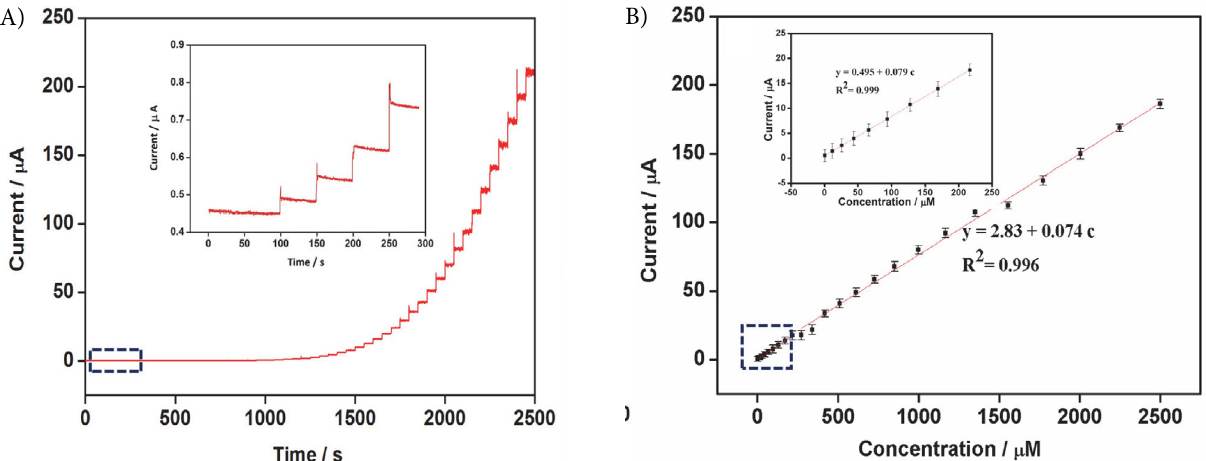
Fig 9. (A) Amperometric responses of the PEDOT/Fe 3 O 4 -CNCC/GCE in stirring PBS (0.2 M, pH 7.4) at an applied potential of 0.8 V to various concentrations of nitrite from 0.5 mM to 2500 mM. Inset shows the magnified amperometric response to the low nitrite concentration (0.5–5 μM). (B) The corresponding calibration plot for the PEDOT/Fe 3 O 4 -CNCC/GCE (the nitrite concentrations were 0.50, 11.7, 25.6, 43.7, 65.9, 93.6, 128.0, 216.7, 270.8, 337.7, 417.2, 508.9, 612.1, 726.4, 851.2, 997.9, 1165.2, 1351.2, 1554.2, 1772.4, 2003.9, 2246.9 and 2500.0 μM in sequence). Inset shows the corresponding calibration plot for the low nitrite concentration (0.50–270.8